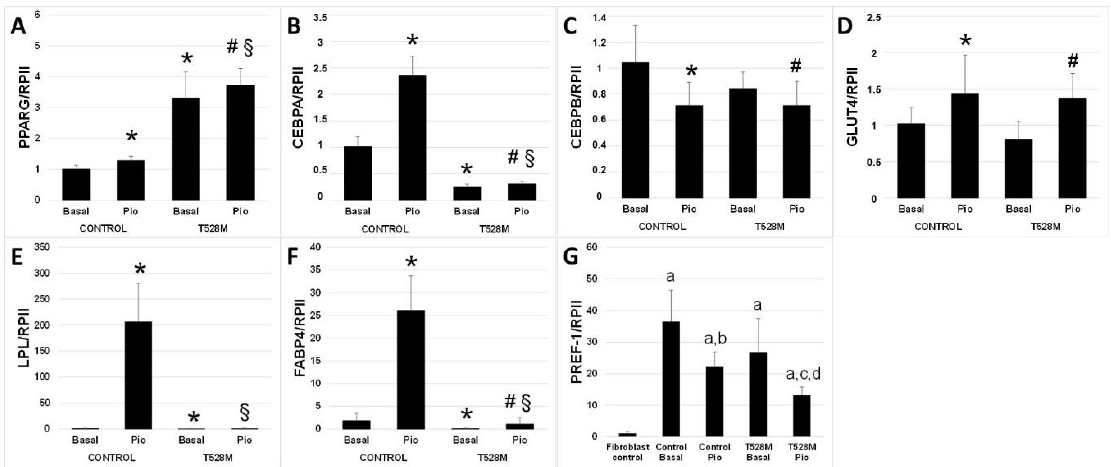
Figure 5. Relative expression of adipogenic genes. Relative expression of adipogenic genes: ( A ) PPARG , ( B ) CEBPA , ( C ) CEBPB , ( D ) GLUT4 , ( E ) LPL and ( F ) FABP4 ; * p < 0.05 vs. Control, # p < 0.05 vs. T528M Basal, § p < 0.05 vs. Control Pio; and relative expression of the adipocyte marker ( G ) PREF-1 , a: p < 0.001 vs. Fibroblast control, b: p < 0.05 vs. Control basal, c: p < 0.01 vs. T528M basal, d: p < 0.01 vs. Control Pio. All samples were analyzed in triplicate, n = 4. Results were normalized to the RNA polymerase II gene.